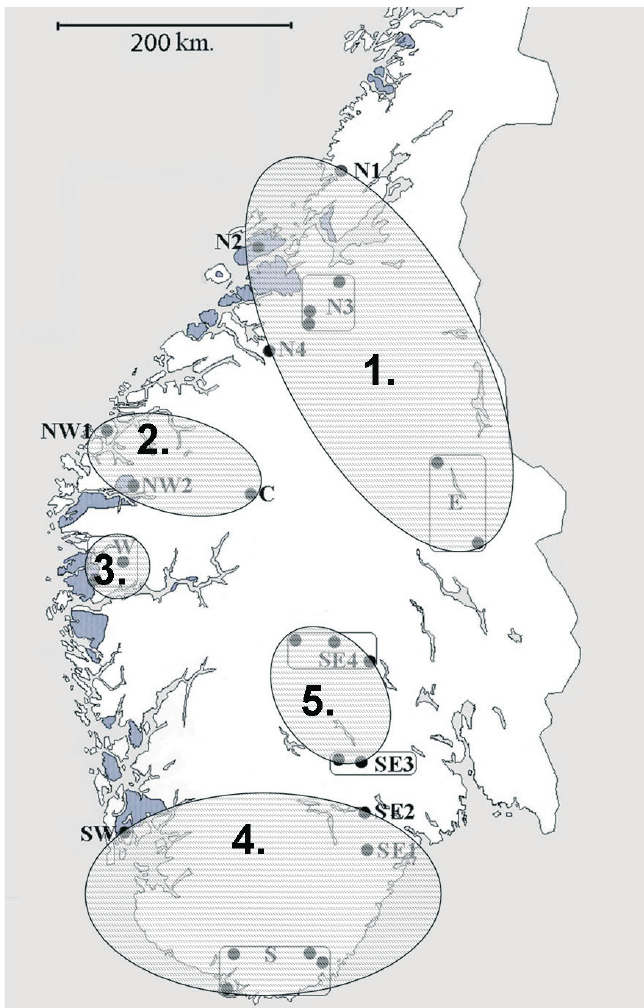
Fig. 1. Sampling localities of Norwegian red deer divided accord- ing to five clusters identified by Bayesian assignment (from Haanes et al ., 2010). Solid grey shading indicates the approximate distri- bution of the population around 1900 (Collett, 1909; Langvatn, 1998), rectangles show combinations of locations to obtain at least 15 individuals per locality and the Bayesian clusters are indicated by transparently shaded